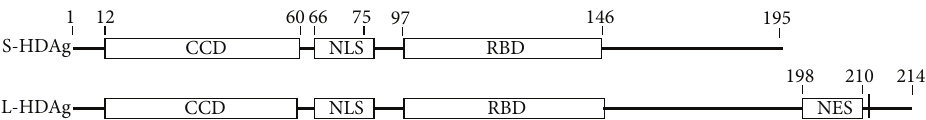
Figure 3: Functional domains of S-HDAg and L-HDAg. The delta antigens share most of their sequence differing only in the 19-amino- acid extension at the C-terminal of L-HDAg. They have, within the common sequence, as represented, a coiled-coil domain (CCD), a nuclear localization signal (NLS), and an RNA binding domain (RBD). Also indicated on L-HDAg are the nuclear export signal (NES) and the unique cysteine, residue 211, which is the target for farnesylation. The numbers indicate the position of the amino acid residues.